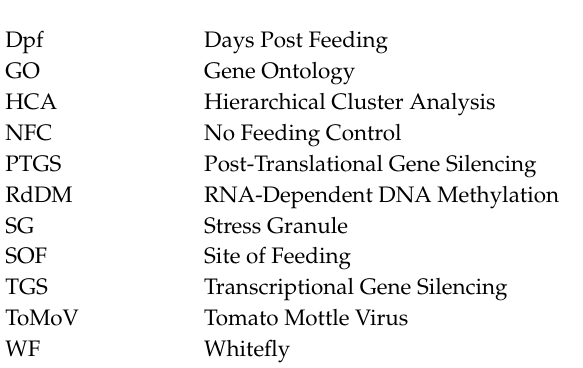
Table S1. Main data analysis file containing IDs, abundance values before and after normalization, ANOVA and pairwise post-hoc statistical analyses, as well as gene ontology enrichment results from each cluster and GOMo promoter